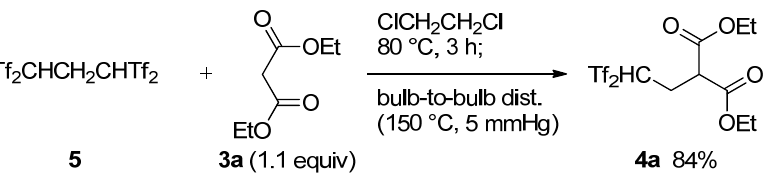
Figure 2. Reaction profile in a 0.01 M solution of Tf (squares, Tf